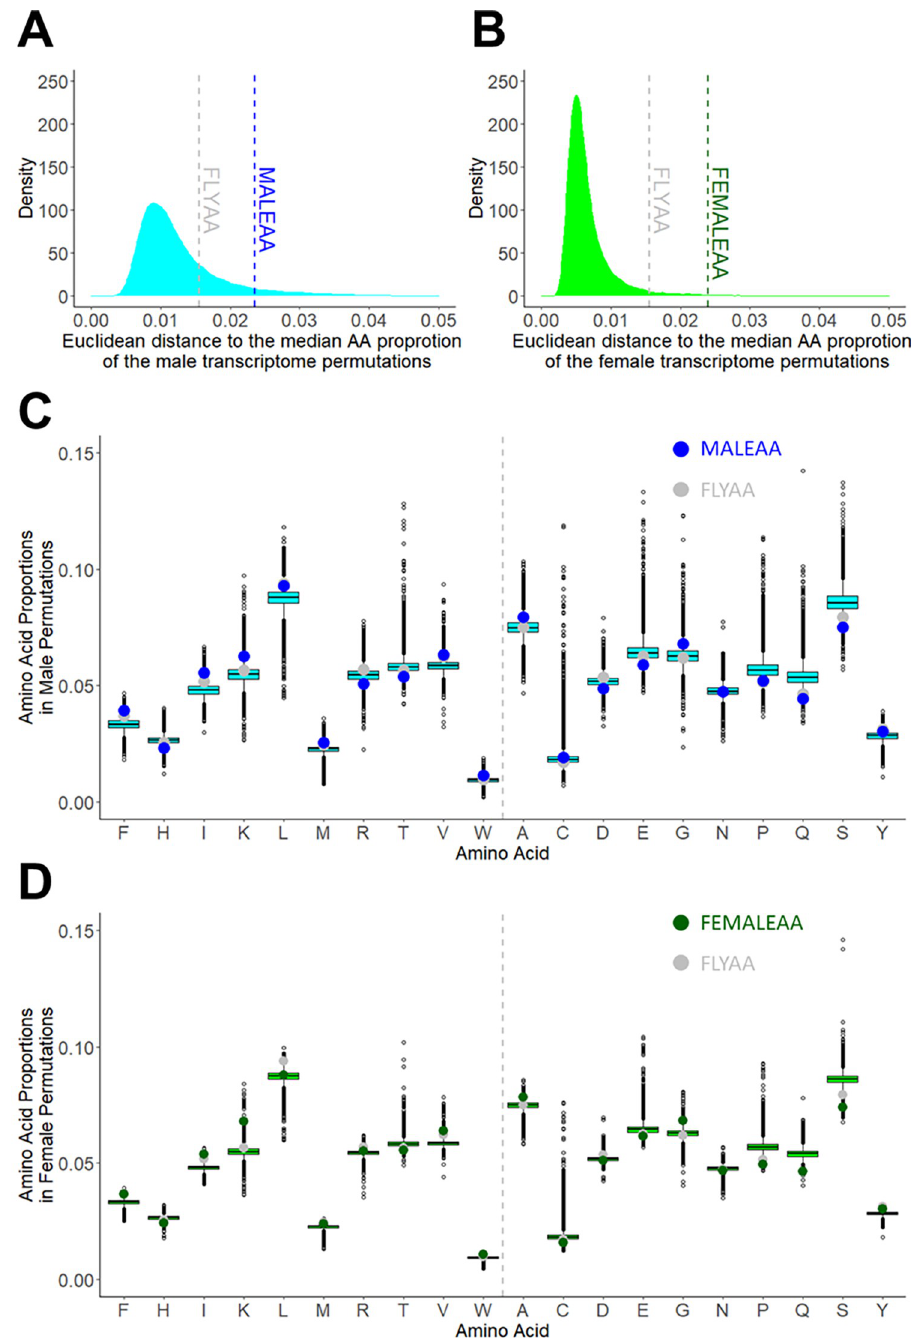
Fig 4. Using permuted transcriptome-weighted AA profiles to compare the way in which the sex-specific transcriptome weighted profiles differ from exome matching. (A, B). We permuted the gene labels in our male (A) and female (B) transcriptome data 20,000 times and calculated a new transcriptome-weighted AA profile for each permutation. We then calculated the Euclidean distances from the median AA proportion of the permuted profiles to each permutation from the male (cyan) (A) and female (light green) (B) transcriptome data as well as the distance to MALEAA (dashed blue line) (A), FEMALEAA (dashed green line) (B) and FLYAA (dashed grey line) (A,B). (C, D) The relative proportion of each AA for all permuted profiles as well as the proportions found for MALEAA (blue) (C), FEMALEAA (green) (D), and FLYAA (grey) (C, D). The vertical grey dashed line separates essential (left) from non- essential (right) AAs. The median AA values are represented by a horizontal line dividing the boxes. The boxes represent the interquartile range (50% of the permuted values) and points shown are values at least 1.5-times the upper and lower interquartile